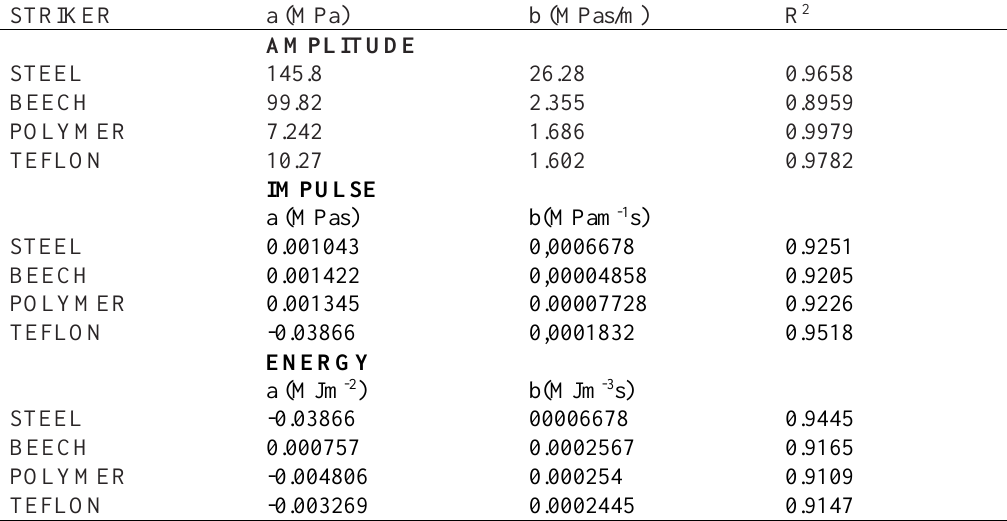
Table 3. Parameters of the Eq.7 (R 2 denotes the coefficient of determination).